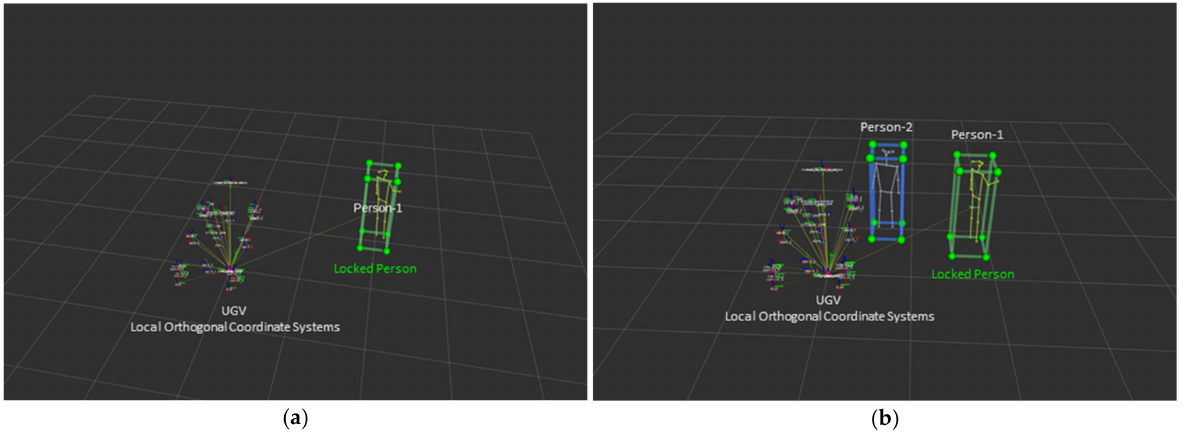
Figure 8. Visualization of the real-time field experiments in ROS RVIZ environment showing the local orthogonal coordinate system of some parts of the UGV, as well as the “following” mode, in case of ( a ) a single person and ( b ) a second person appearing in the field of view of the RGB-D camera.